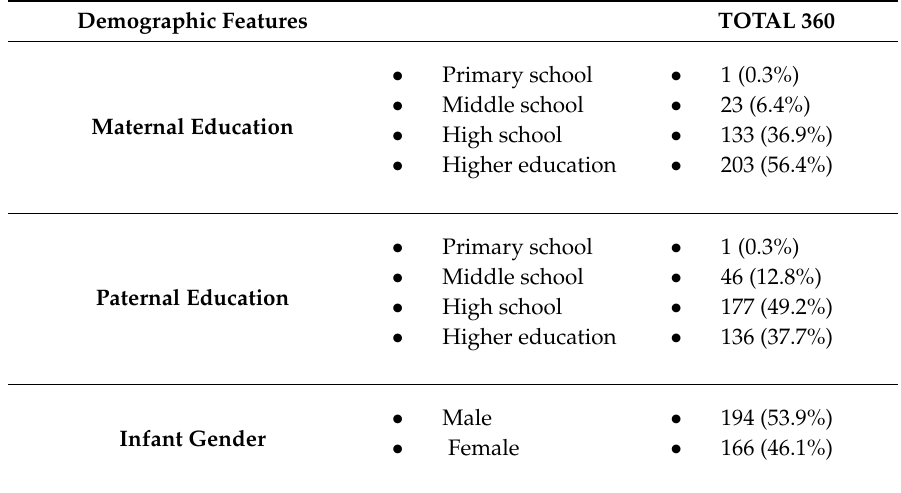
Table 1. Demographic